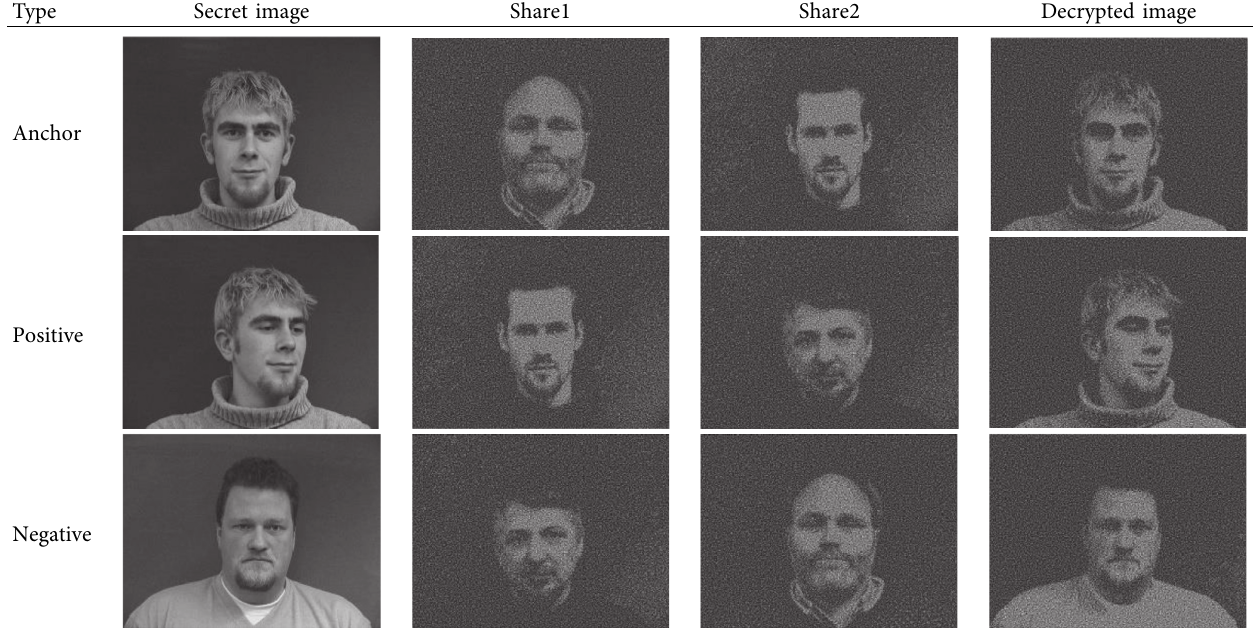
Table 2: The decomposed shares and decrypted images for one